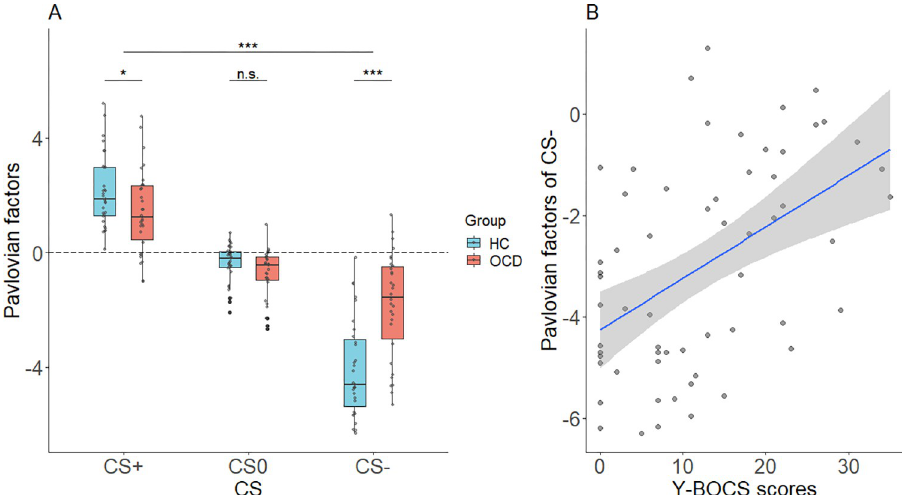
Fig 4. Pavlovian factors in each Pavlovian condition and correlation with Y-BOCS scores. (A) Pavlovian factors in each Pavlovian condition for the OCD and HC groups. The dashed line shows the zero-effect level where Pavlovian factors do not affect instrumental behavior. (B) Y-BOCS scores correlated significantly with Pavlovian factors for CS-.